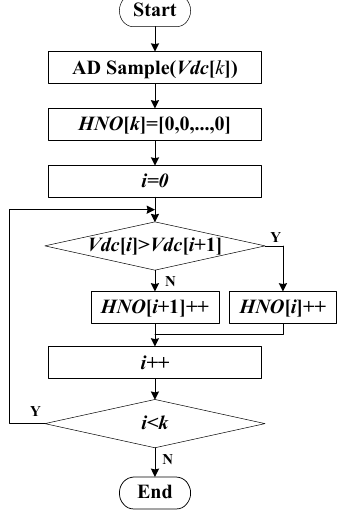
Figure 5. Flowchart of sorting DC voltage function in DSP.